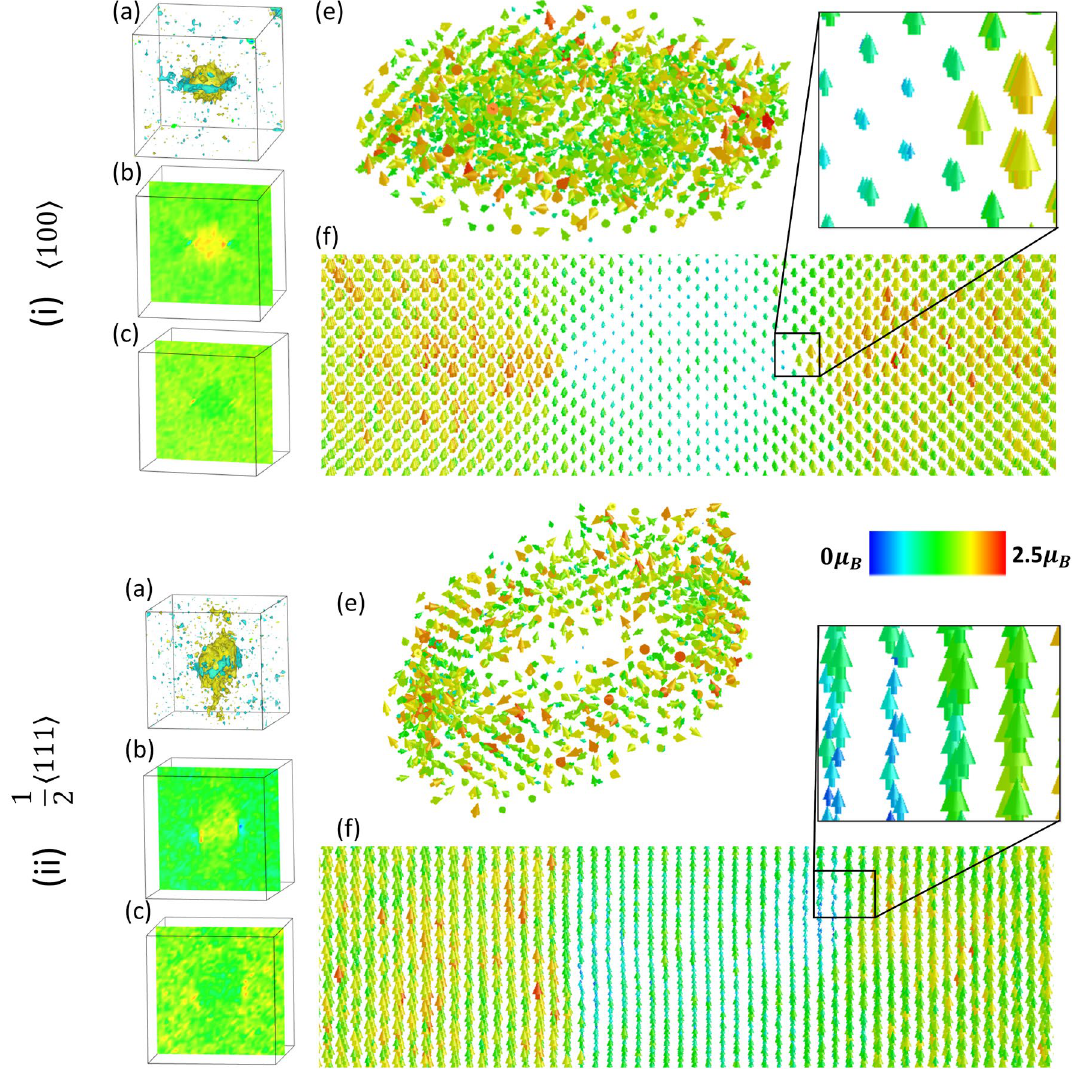
1 111 100 and (ii) interstitial 2 (cid:31) (cid:30) (cid:31) (cid:30)